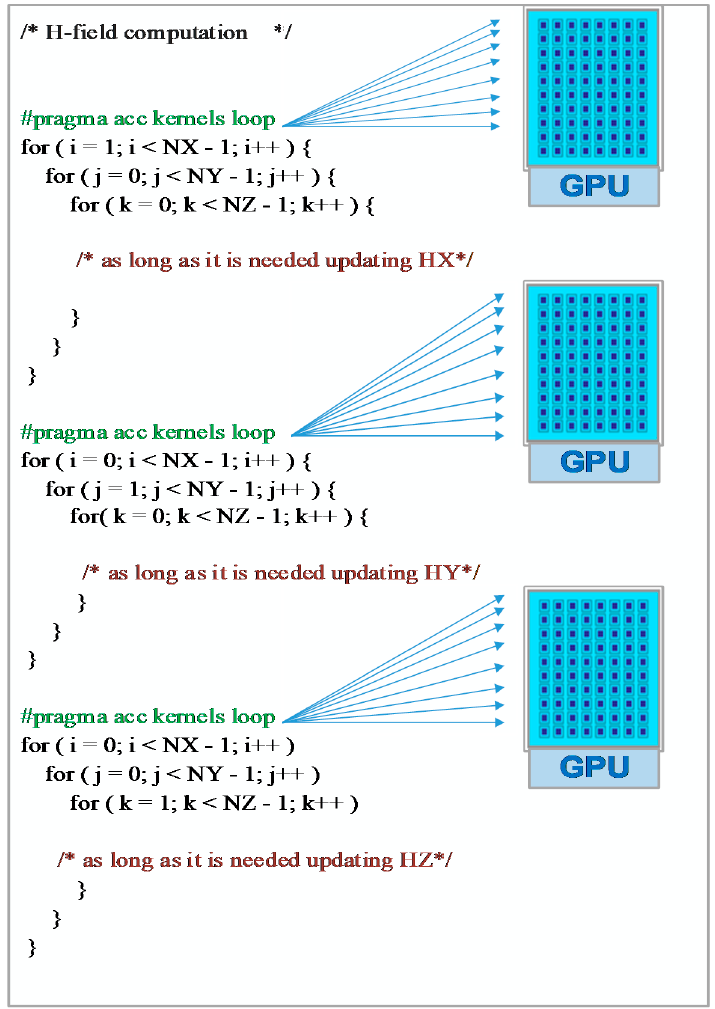
Figure 5. Mapping parallelism onto the hardware.